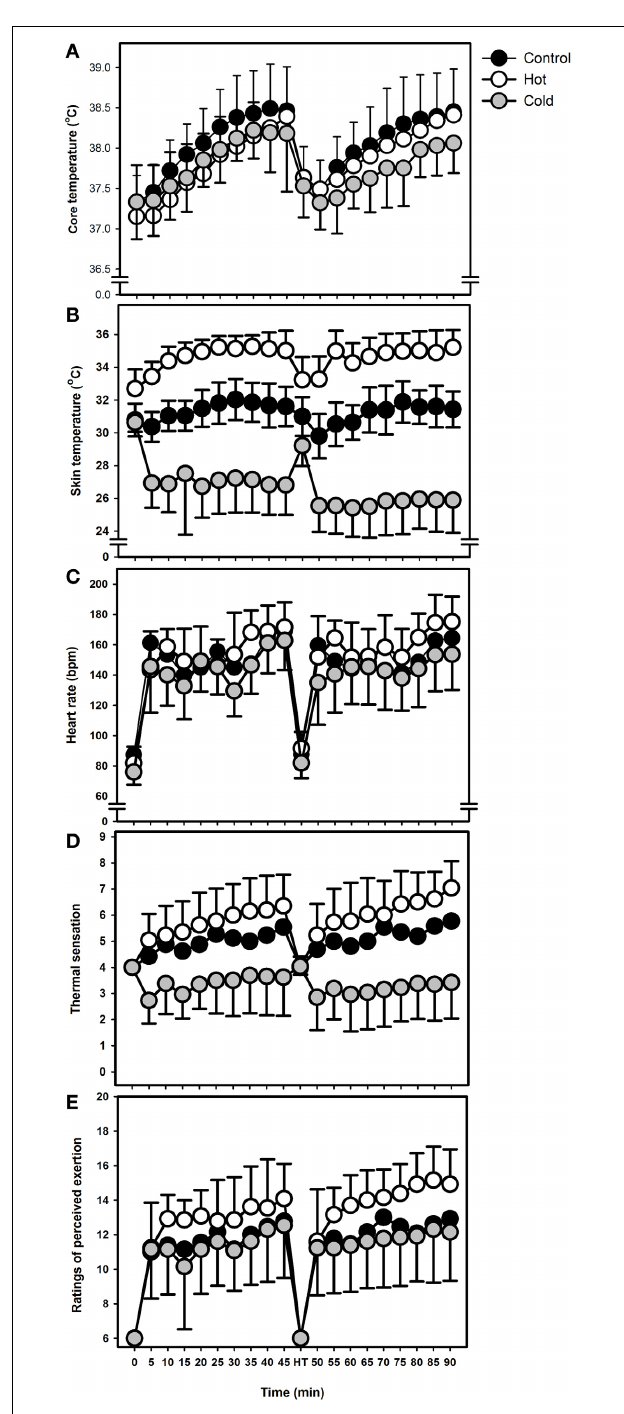
FIGURE 2 | (A) Mean (SD) rectal temperature during the 90min intermittent sprint exercise protocol in CONT, HOT and COLD conditions. (B) Mean (SD) skin temperature during the 90min intermittent sprint exercise protocol in CONT, HOT, and COLD conditions. (C) Mean (SD) heart rate during the 90min intermittent sprint exercise protocol in CONT, HOT, and COLD conditions. (D) Mean (SD) thermal sensation during the 90min intermittent sprint exercise protocol in CONT, HOT, and COLD conditions. (E) Mean (SD) ratings of perceived exertion during the 90min intermittent protocol in CONT, HOT, and COLD